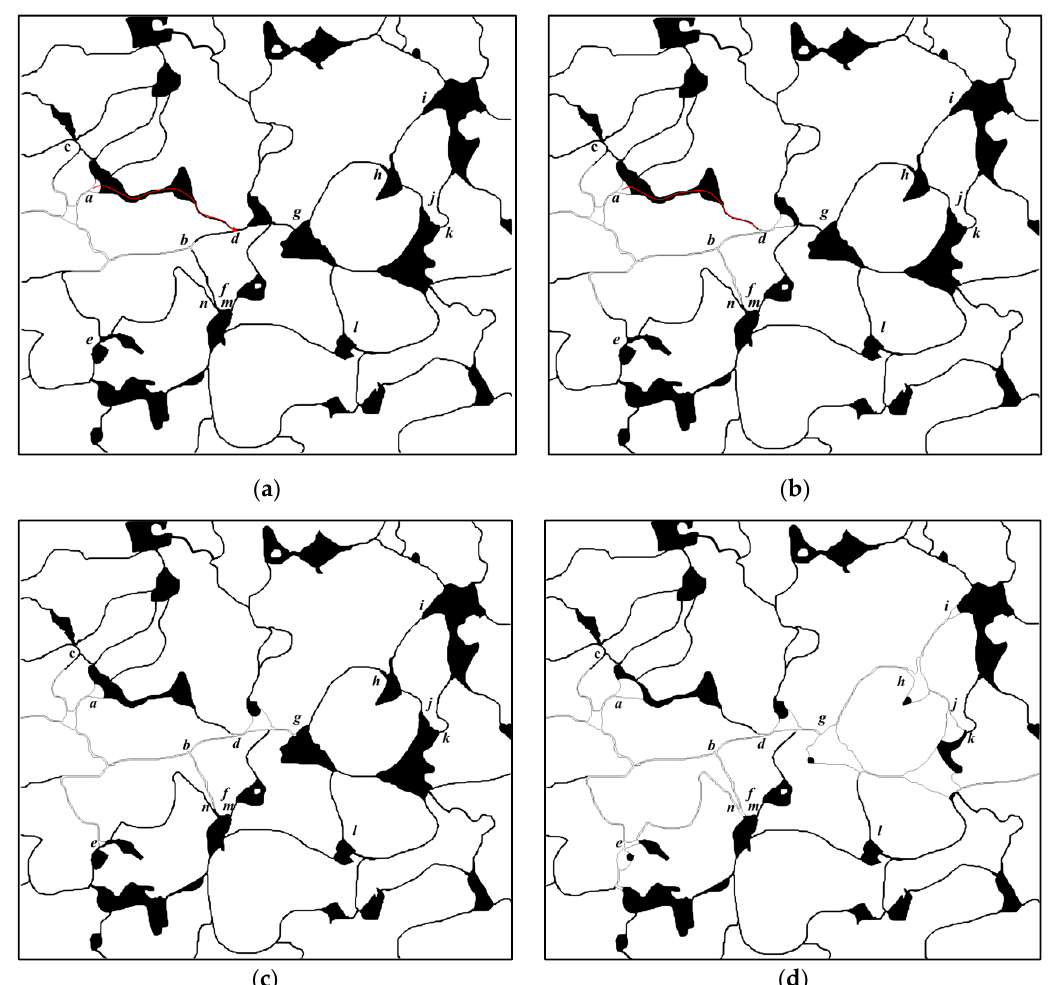
Figure 12. Oil and water distribution at different times, at the injection velocity of 0.03 m · s − 1 (Ca = 4.29 × 10 − 4 ): ( a ) 0.19 s, ( b ) 0.31 s, ( c ) 0.39 s, ( d ) final. Different positions are indicated by lower case letters. Table 5. Blockage and restart information at different locations during the injection process, at